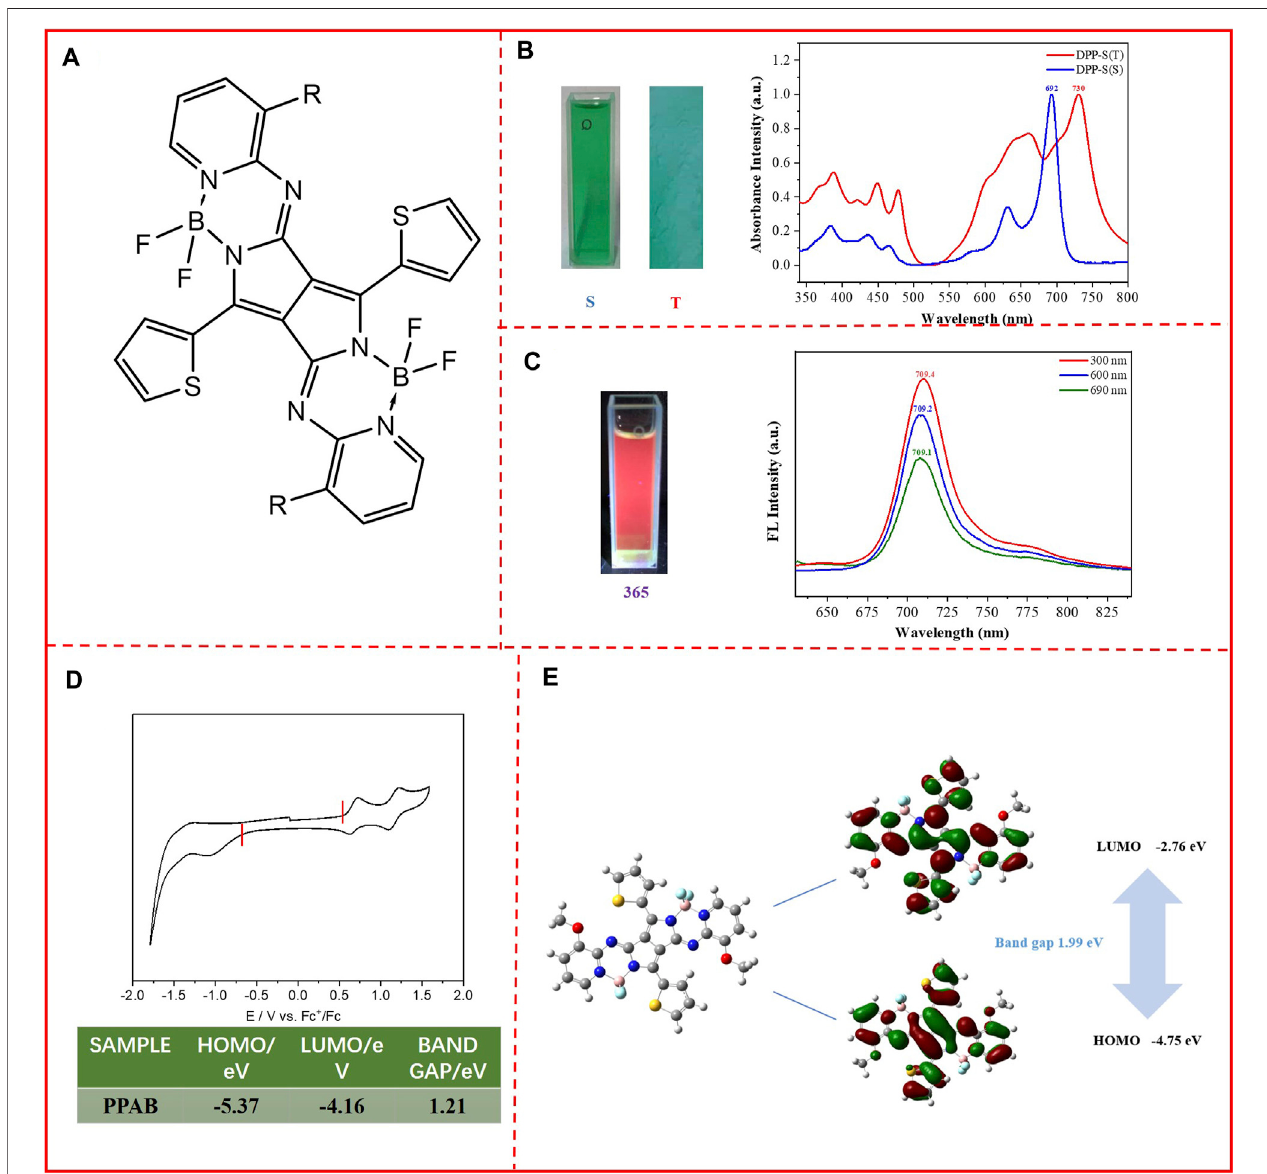
FIGURE1 |(A) Chemical structure ofPPAB; (B) photos ofPPAB in thechloroform solution (left)and inthe thin fi lmstate (right). UV/visabsorption spectra ofPPAB in thechloroform solution(S)and thin fi lms (T); (C) photos ofPPABinthechloroform solutionexcitedby365 nmlight; PLspectraofPPABinchloroform,excited by300, 600, and 690 nm; (D) cyclic voltammograms ofPPAB. Electrolyte: 0.1 MTBAPF 6 in acetonitrile.Potential calculated vs.ferrocene. Scanrate:100 mV s − 1 ; T =25 ° C; (E) computational calculations of the simpli fi ed PPAB obtained at the B3LYP/6-31G* level and molecular orbital surfaces of the HOMO and LUMO energy levels and the band gap of